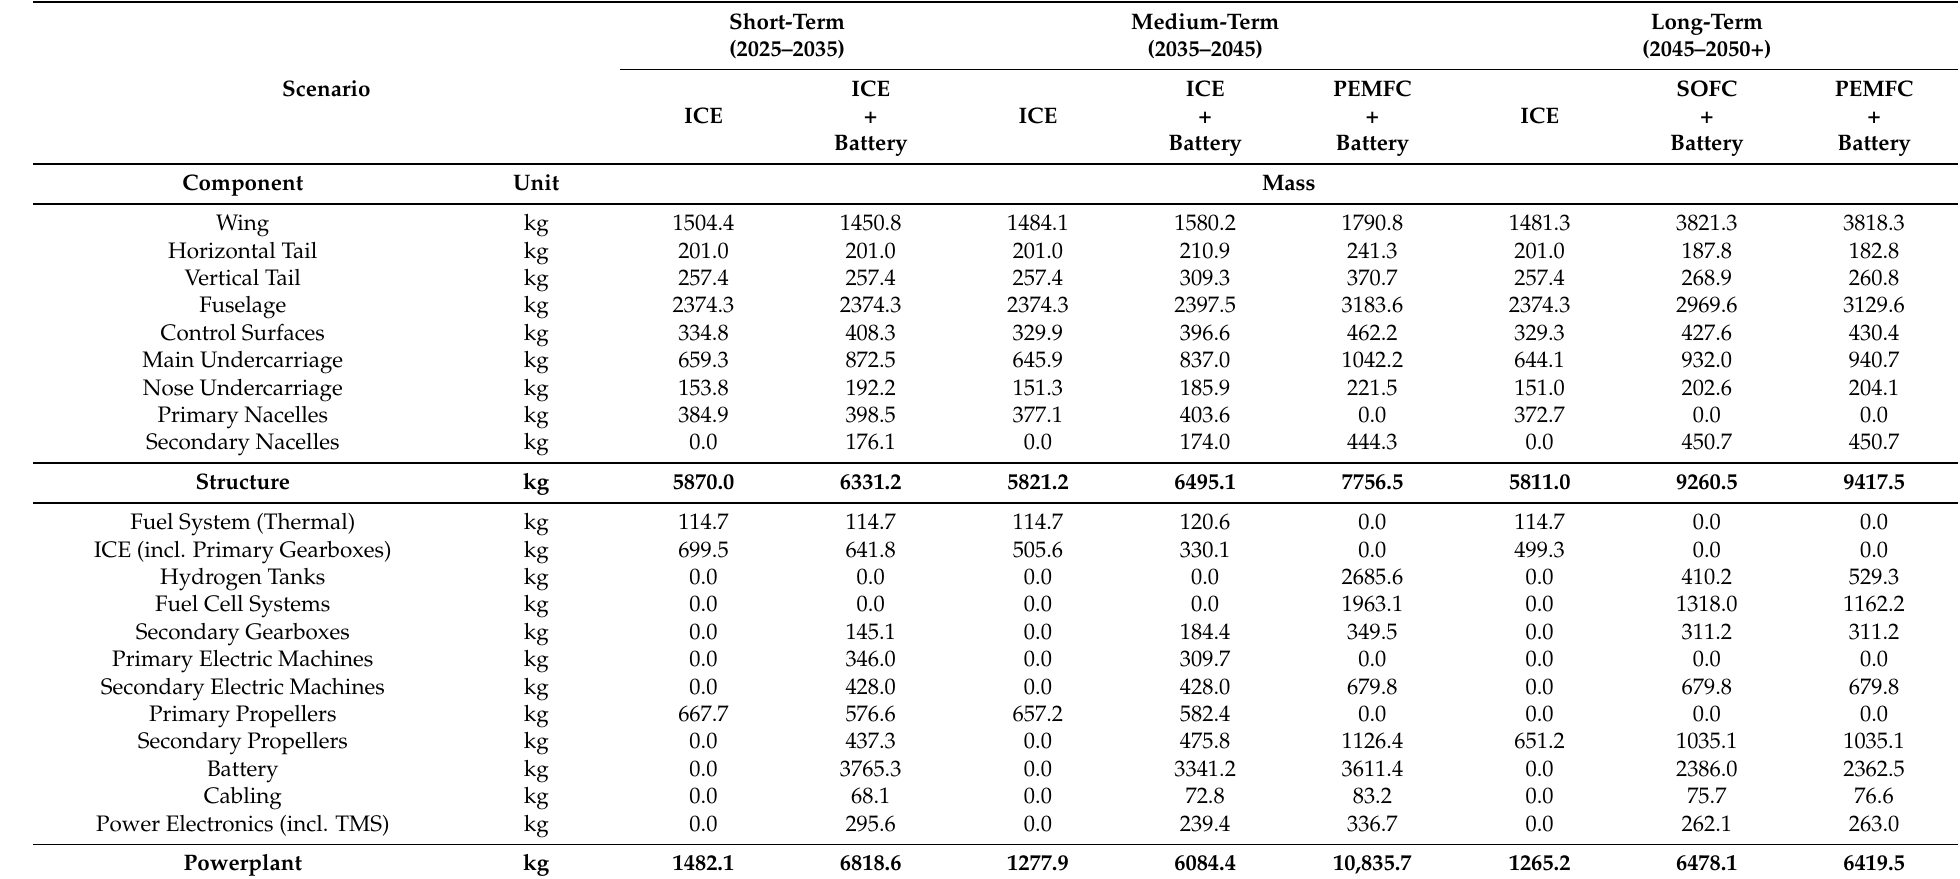
Table 10. Mass breakdown of the final future scenarios defined for different time horizons and using different powertrain